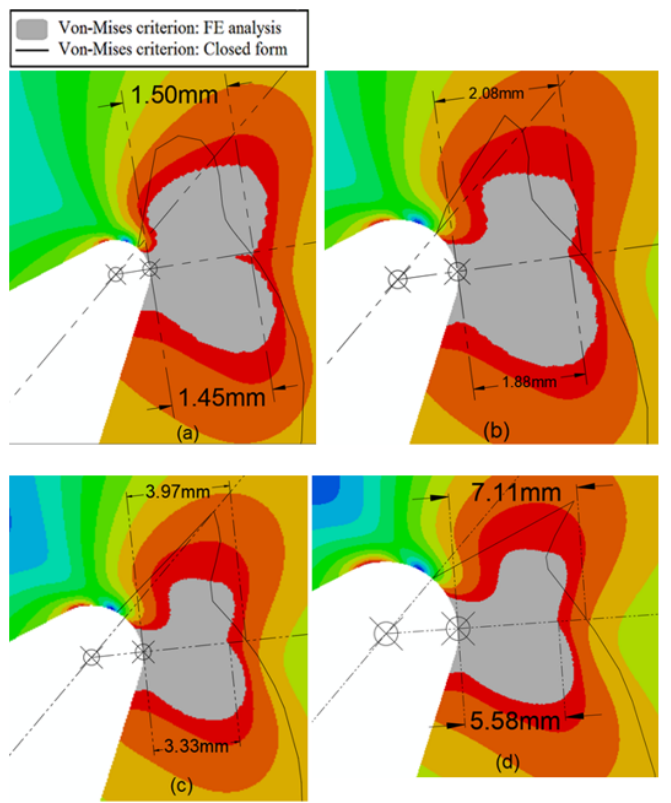
Figure 9. Plastic zones obtained from FE analyses and the proposed methodology based on the von Mises yield criterion, with notch tip radii of ( a ) 0.5 mm, ( b ) 1 mm, ( c ) 2 mm, and ( d ) 4 mm. Notch rotation angle = 50°. Applied loads were 40, 43, 50, and 55 kN, respectively.